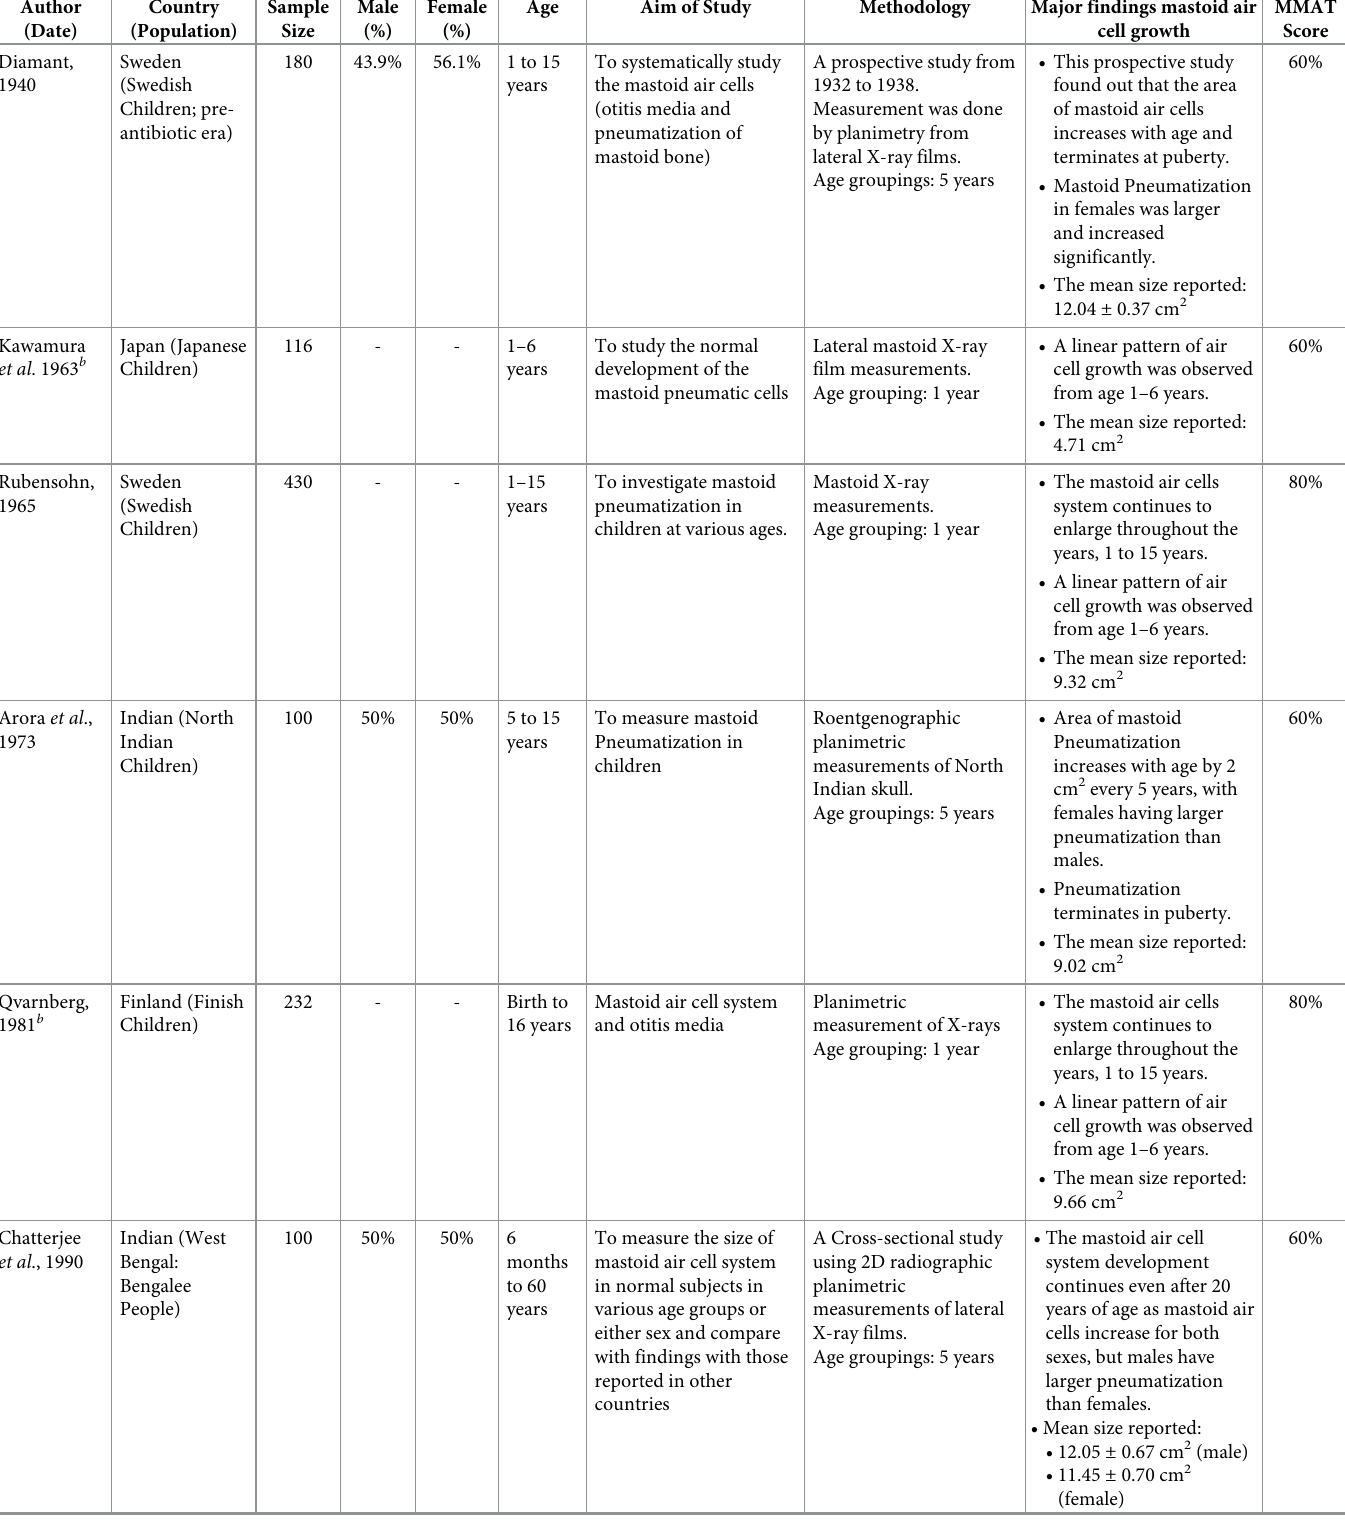
Table 2. Table of characteristics of included